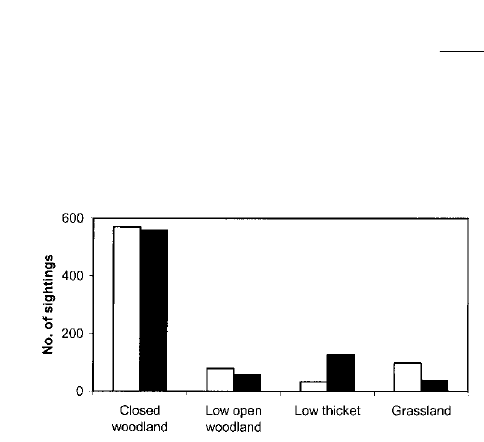
Fig. 6. Habitat selection by lion in Makalali. The actual number of sightings (clear bars) and expected (black bars) number of sightings in the four habitat types